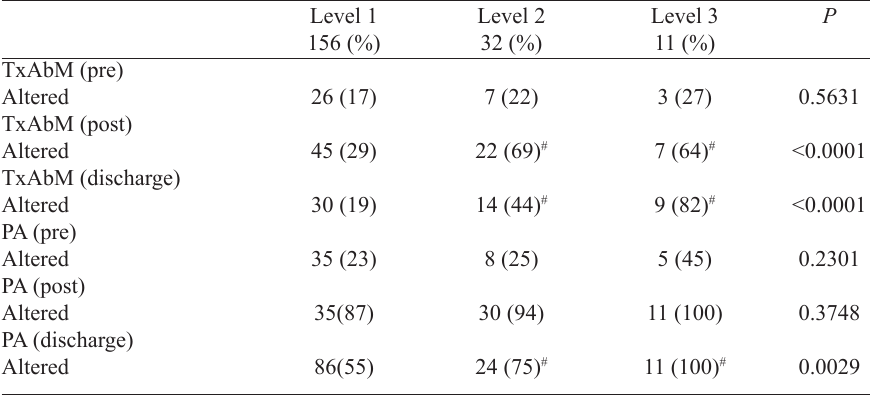
Table 3. Qualitative variables of the classification system in the 3 levels of assistance.